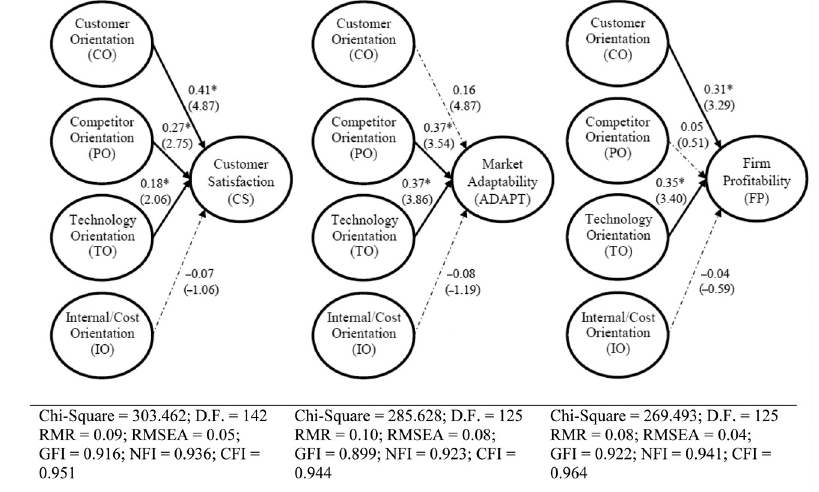
Figure 2. The analyses of alternative